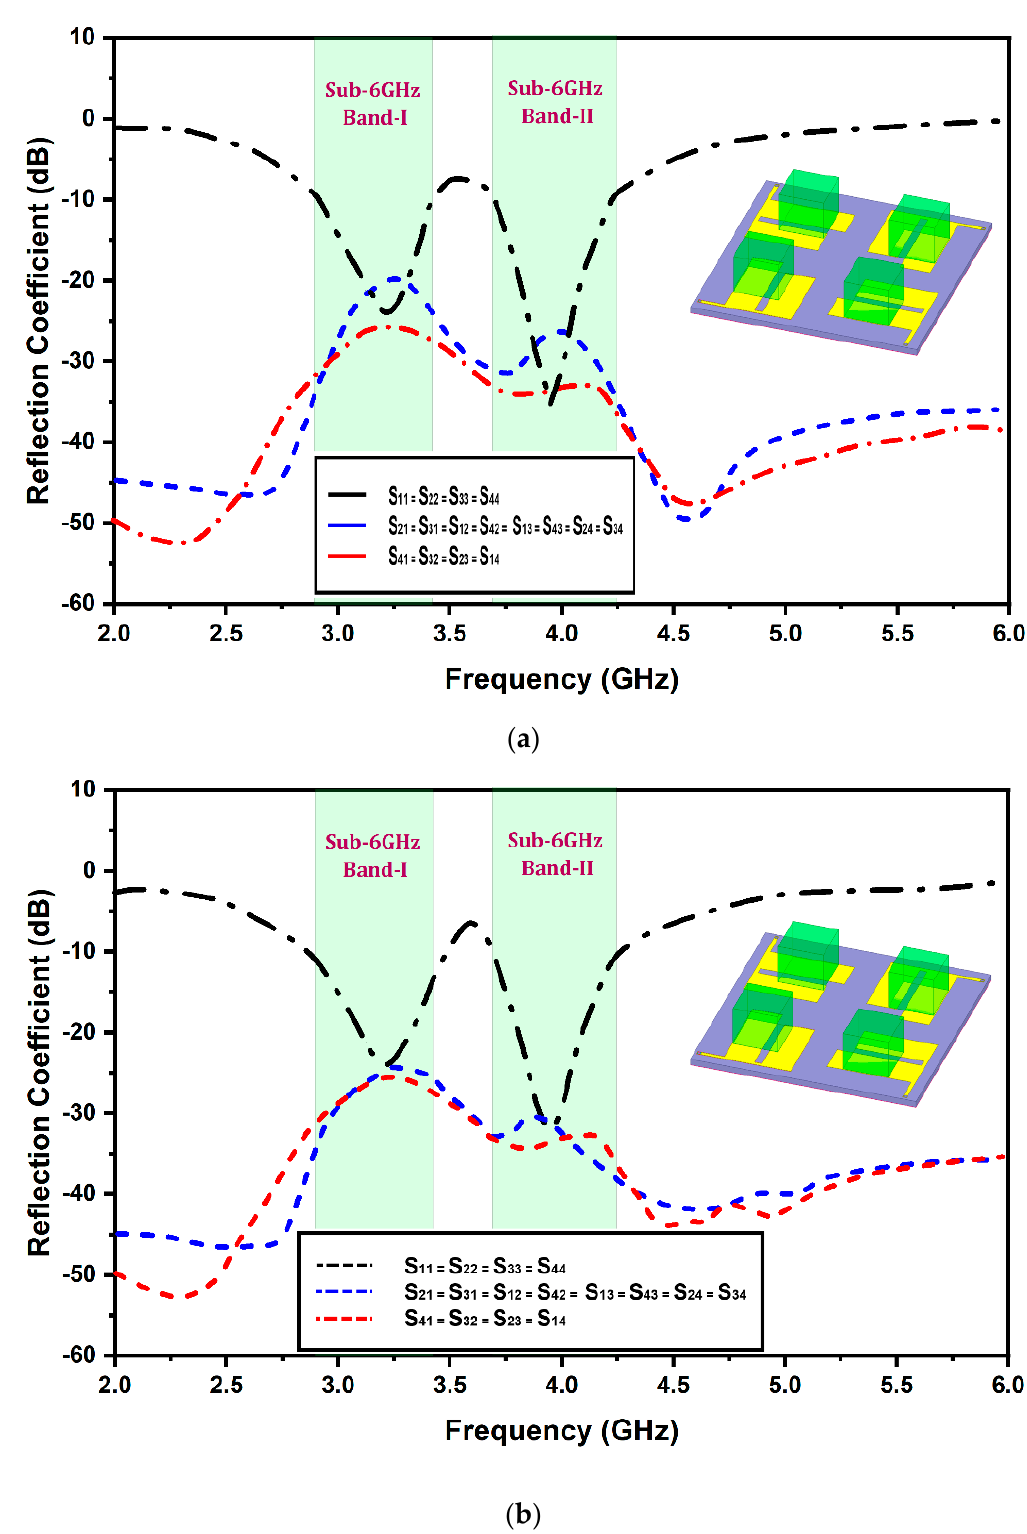
Figure 7. Antenna reflection coefficient; ( a ) simulated; and ( b ) measured.